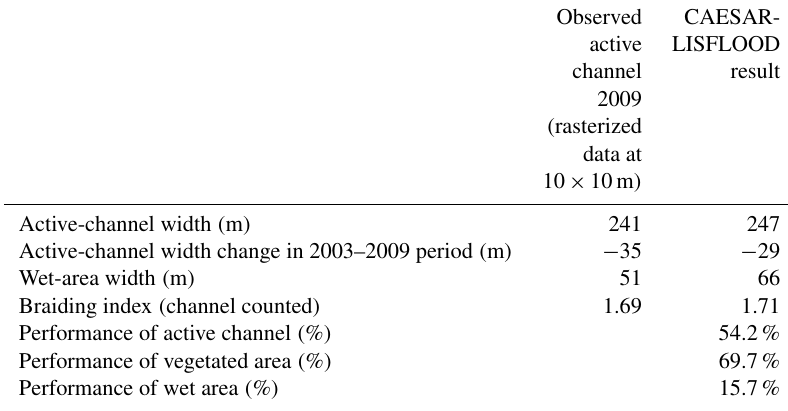
Table 4. Results of CAESAR-LISFLOOD